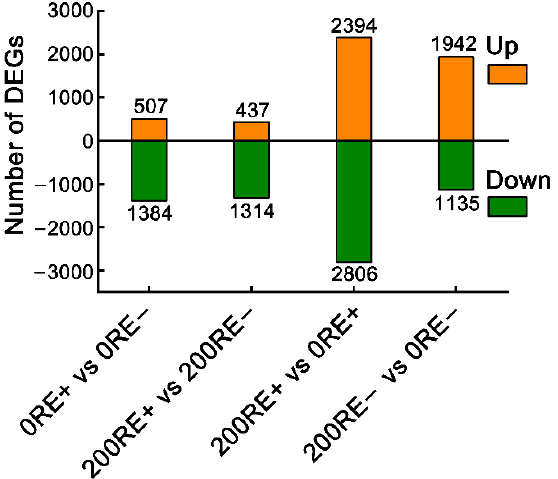
Figure 2. The number of up- and down-regulated DEGs in comparative groups of 0RE+ versus 0RE − (abbreviated as 0RE+ vs. 0RE − ), 200RE+ vs. 200RE − , 200RE+ vs. 0RE+, and 200RE − vs. 0RE − .